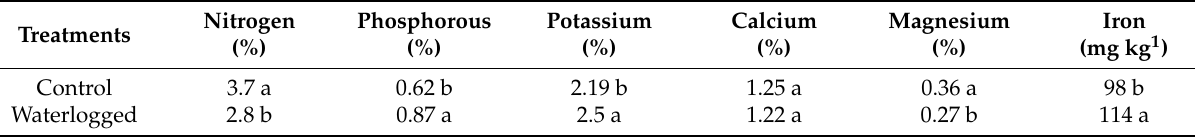
Table 2. Nutrient concentration in flooded and control soybean plants at the reproductive stage in response to waterlogging